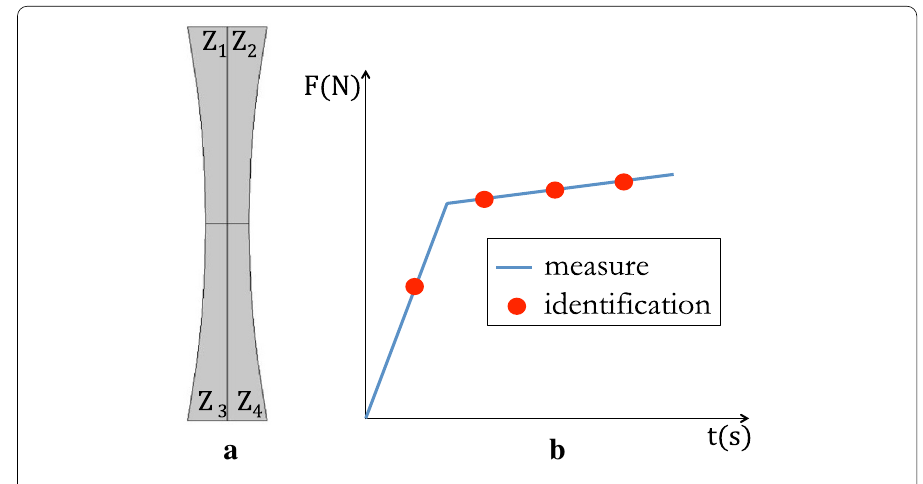
Fig. 5 a Geometry and identification domains and b the 5 load steps